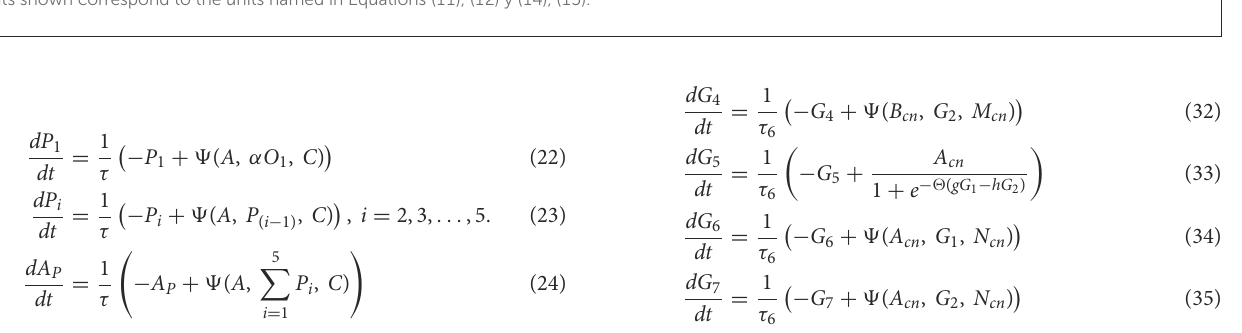
FIGURE3 Memory linear chain. Two circuits similar to that shown above, process the propagation of the short-term memory circuit (Figure 2). The five processing units shown correspond to the units named in Equations (11), (12) y (14),